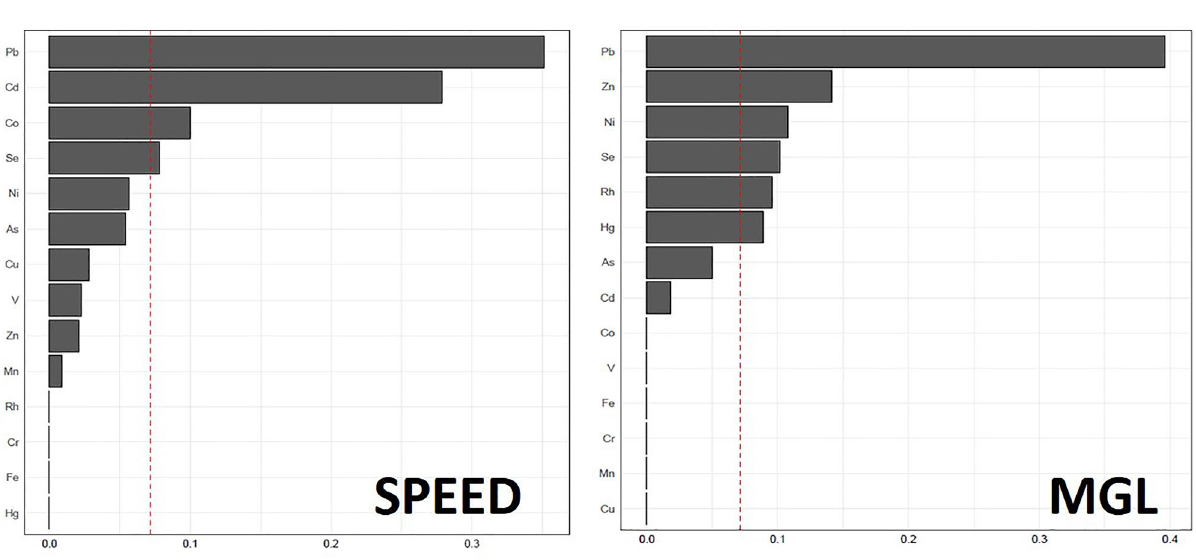
Figure 4. Associations between tear trace elements and dry eye disease parameters based on weighted quantile sum